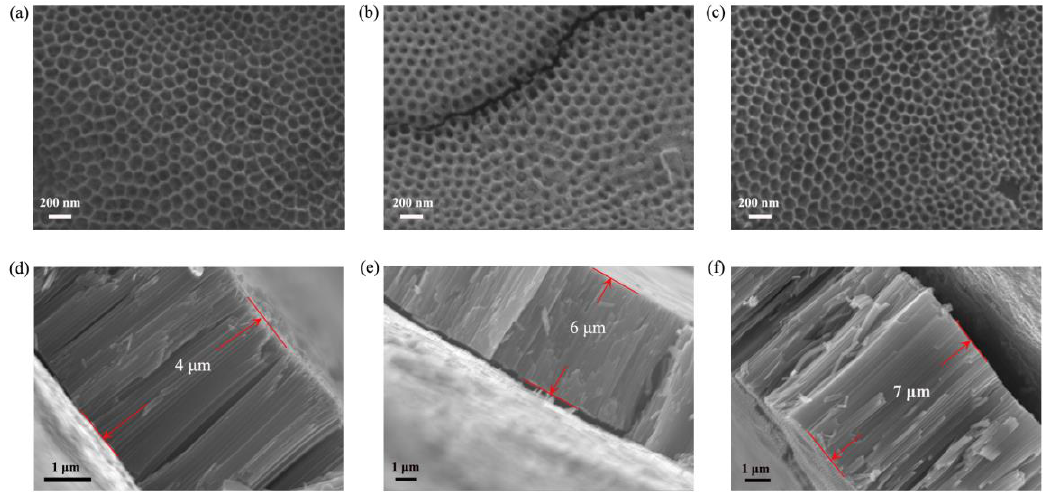
Figure 2. Scanning electron microscopy images of TNAs with different tube lengths: ( a ) top and ( d ) side views with secondary oxidation time of 1 h; ( b ) top and ( e ) side views with secondary oxidation time of 2 h; ( c ) top and ( f ) side views with 3 h oxidation time.